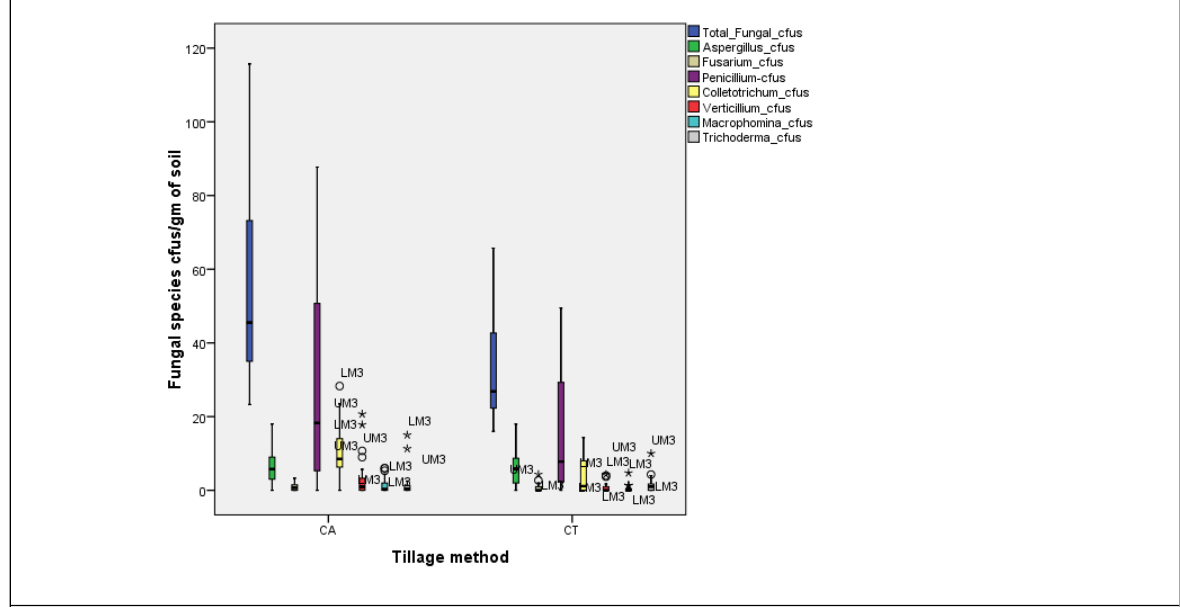
Figure 3: Box and whisker diagram after removal of 4 outlier farms